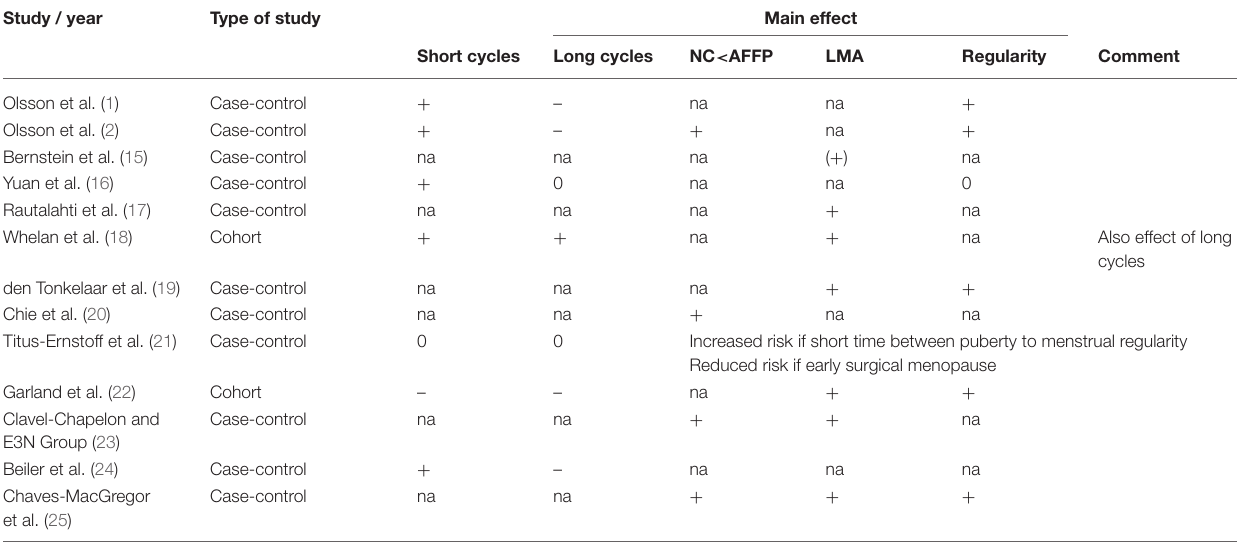
TABLE 1 | Studies of different menstrual cycle characteristics and breast cancer